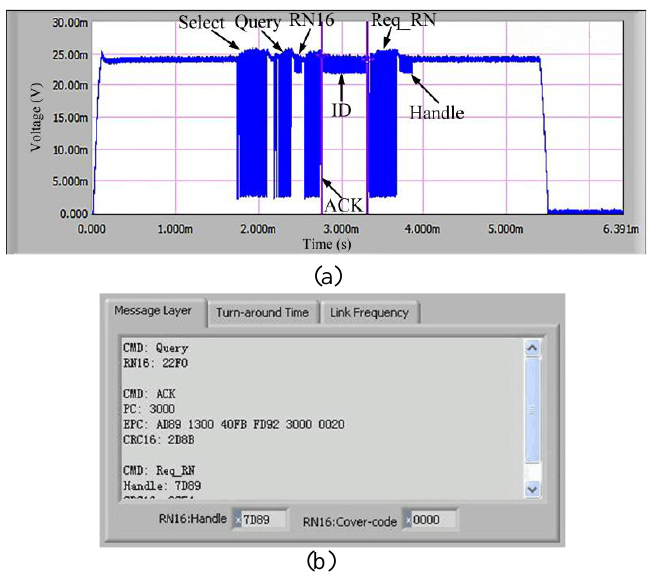
Figure 8. Overall communication flow: ( a ) corresponding waveform; ( b ) corresponding data.